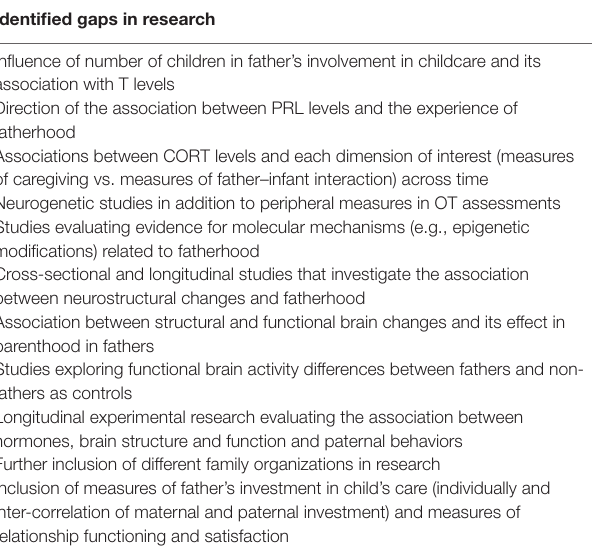
TABLE 2 | Systematic framework for future